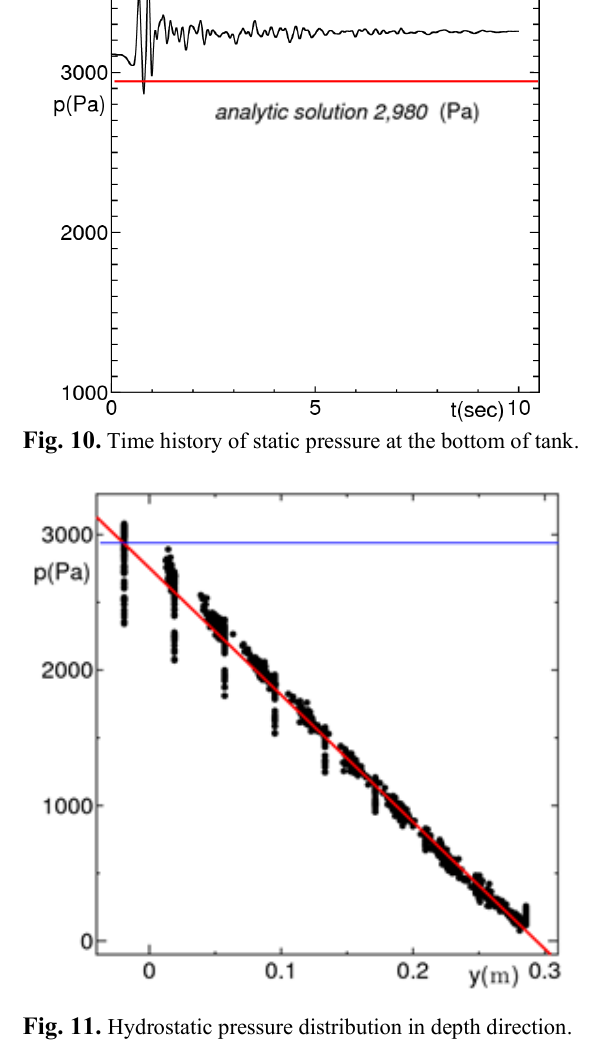
Fig. 12. Initial particle arrangement for dam break simulation (X2 model).